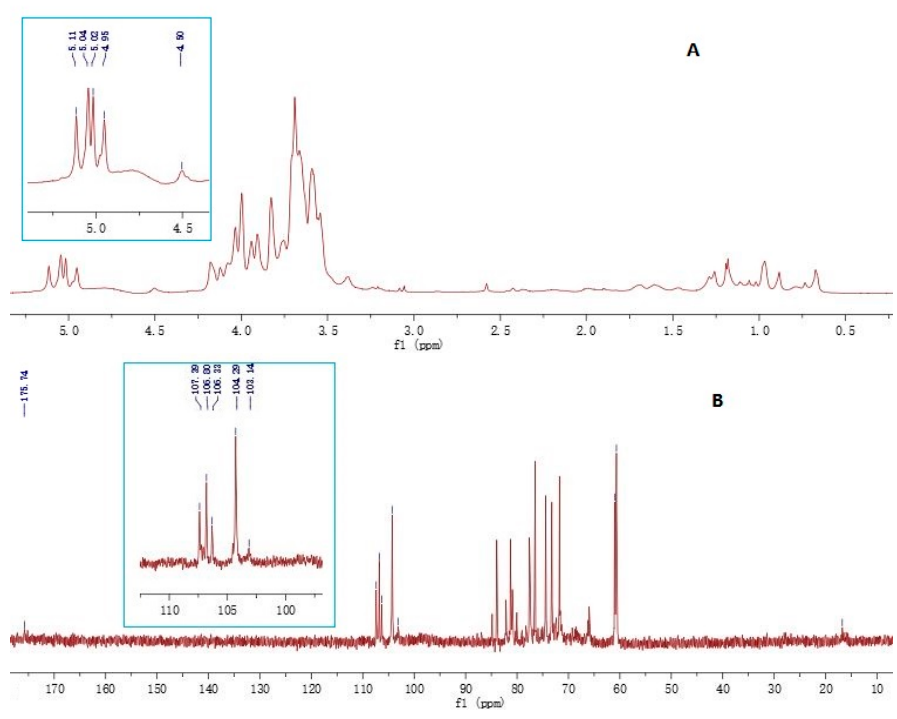
Figure 3. The 1 H- and 13 C-NMR spectra of polysaccharide fraction SJZDP-II-I. ( A ) 1 H-NMR spectra of